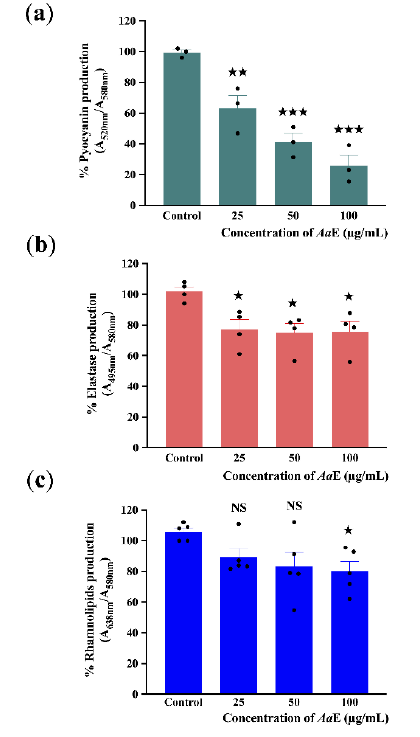
Figure 2. Effect of Aa E on P. aeruginosa pyocyanin ( a ), elastase ( b ), and rhamnolipid ( c ) virulence factor production. P. aeruginosa was grown in the absence or presence of Aa E at 25, 50, and 100 µg/mL. All results were normalized against cell density (A 580nm ). Data represent mean ± SEM of at least three independent biological assays. Significant differences between mean values versus control were assessed via GraphPad Prism 8 t- test calculator. ★★★ , p = 0.0001–0.001; ★★ , p = 0.001–0.01; ★ , p = 0.01–0.05; NS : (not significant), p > 0.05.